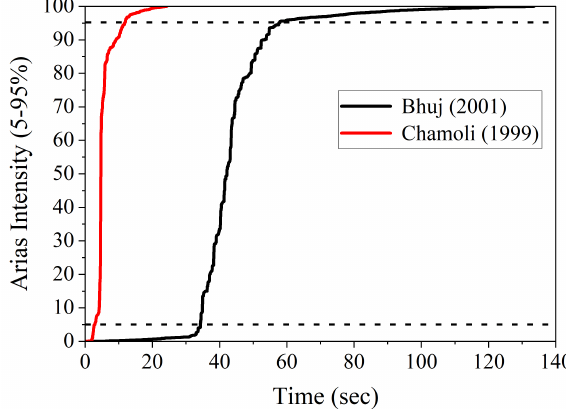
Fig. 3. Arias Intensity (AI) for Bhuj (2001) and Chamoli (1999)